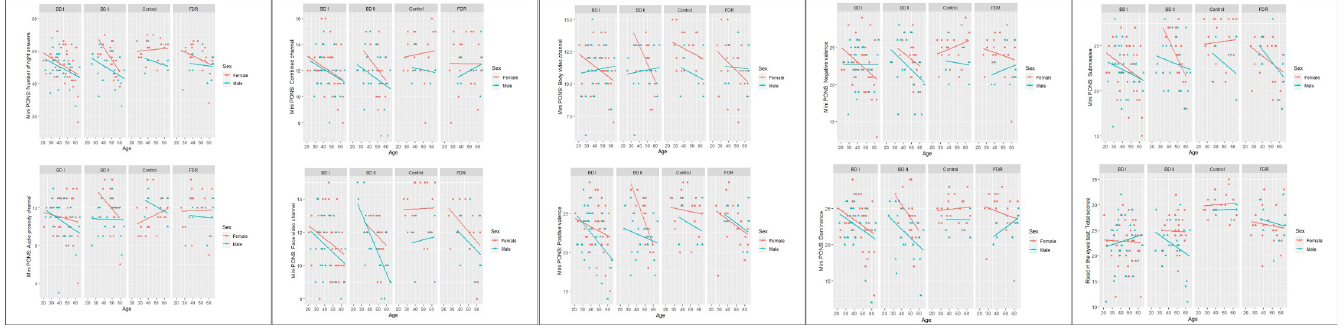
Fig 2. Scatterplots: Role of group, sex and age in the study